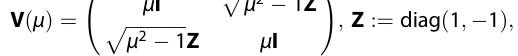
p ffiffiffiffiffiffiffiffiffiffiffiffiffi μ 2 (cid:2) 1